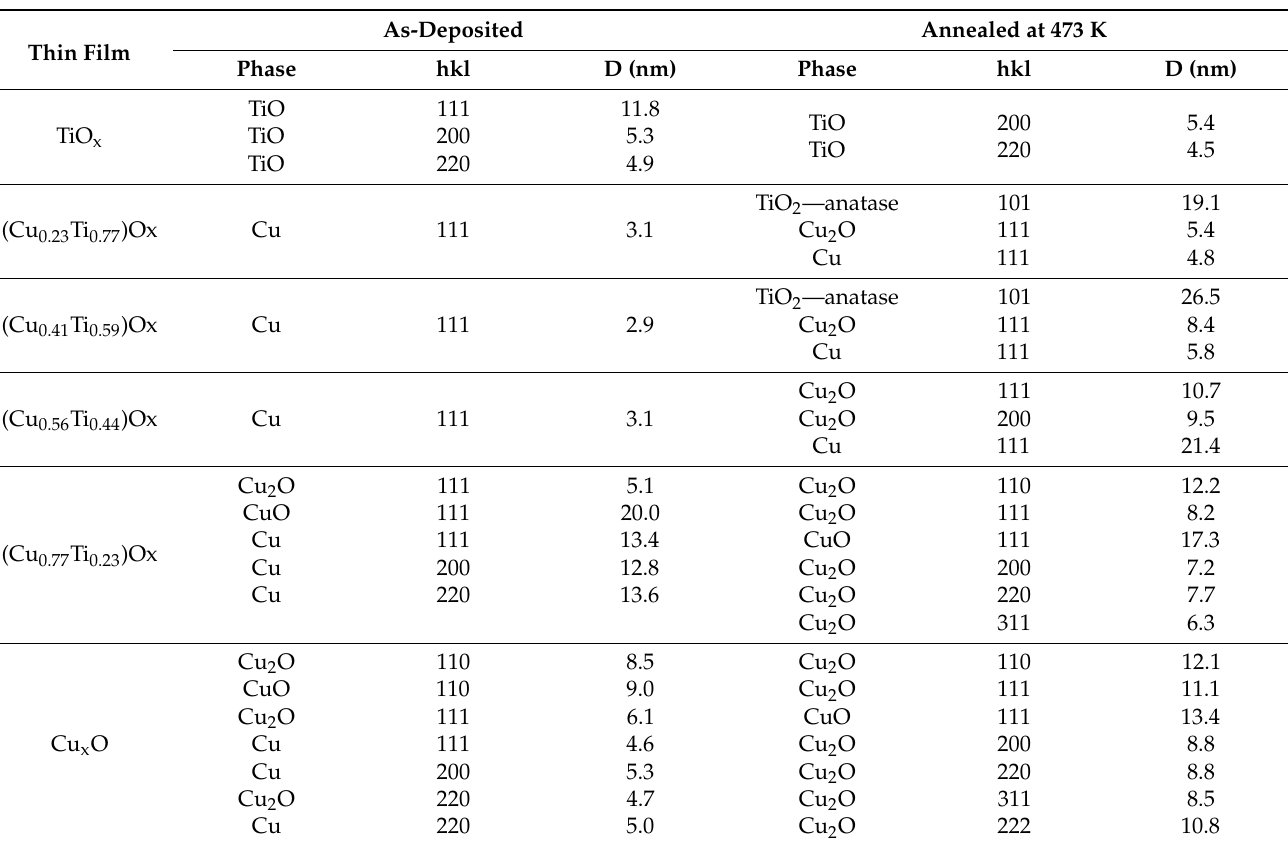
Table 2. Summary x-ray diffraction structure analysis of as-deposited and annealed (CuTi)Ox thin